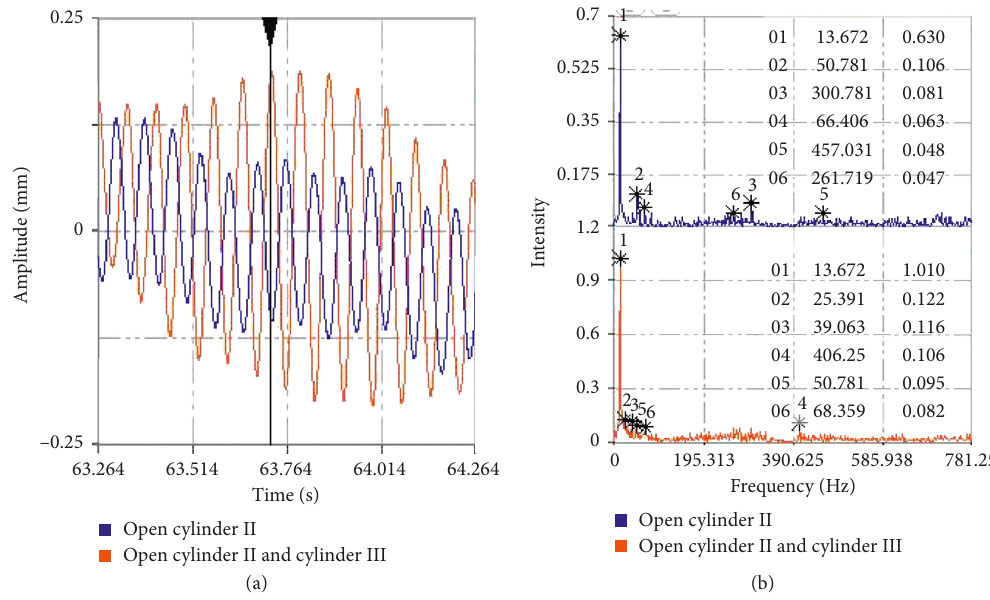
Figure 14: Vertical displacement of the bearing housing of cylinder III in 1s. (a) Time-vertical displacement curve in 1s. (b) Time-frequency spectrogram. Table 8: Vertical vibration parameters of the bearing housing of cylinder I and cylinder II. The bearing housing of cylinder I The bearing housing of cylinder II Measuring point of running cylinder Cylinder I Cylinder I and cylinder